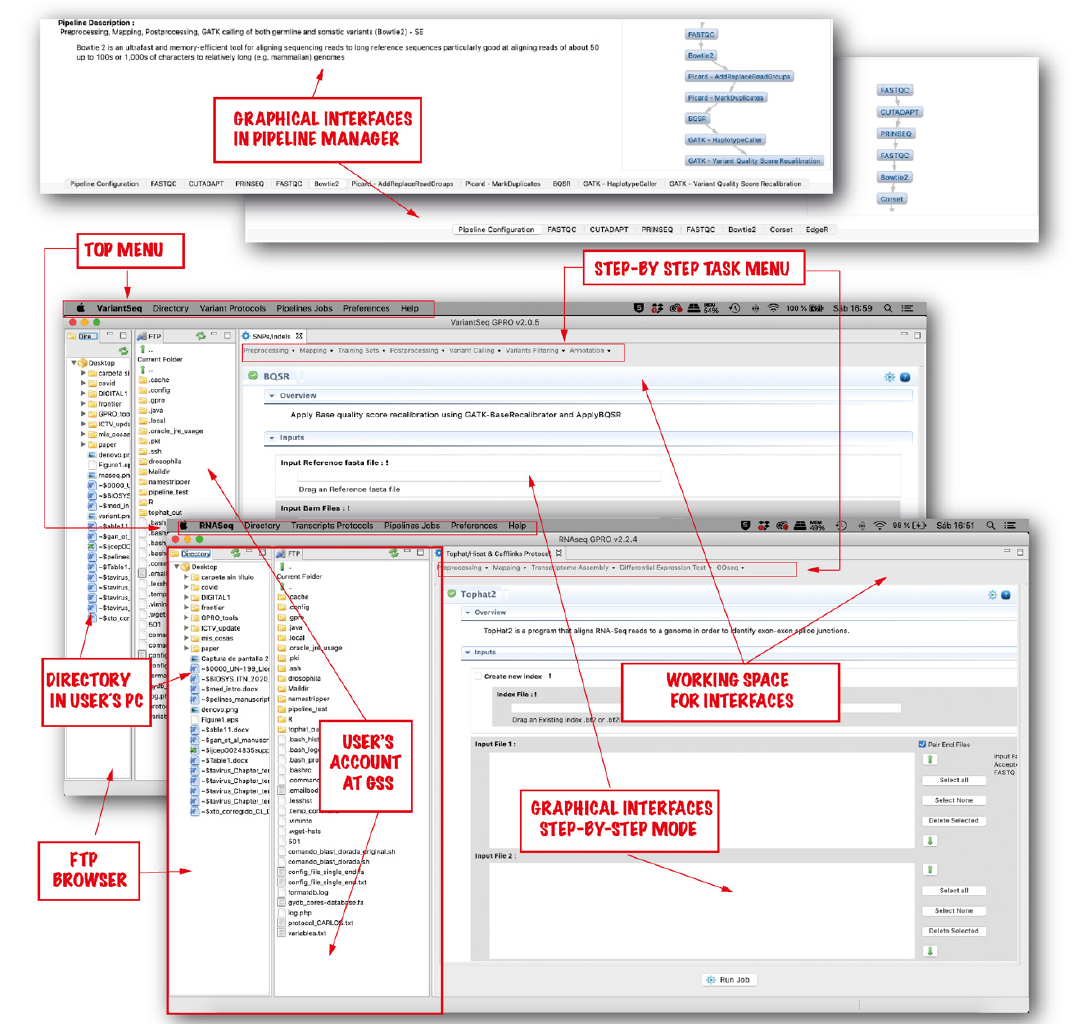
Figure 2. User interfaces of “ RNASeq ” and “ VariantSeq ” . Both applications have a common interface. The general procedure is as follows. Once an application has been linked to the GSS, the user should follow the subsequent steps. (first) Transfer the input files from the user’s PC directory to the GSS using the FTP browser. (second) Select the computational mode (it can be step-by-step or pipeline- like) (third) Drag the input files (fastq files, reference sequences, GTF/GFF files, Training Sets, etc.) from the GSS to the input fields of the selected interface/s. (fourth) Declare the output. (fifth) Set options and parameters. (sixth) Run the analysis.